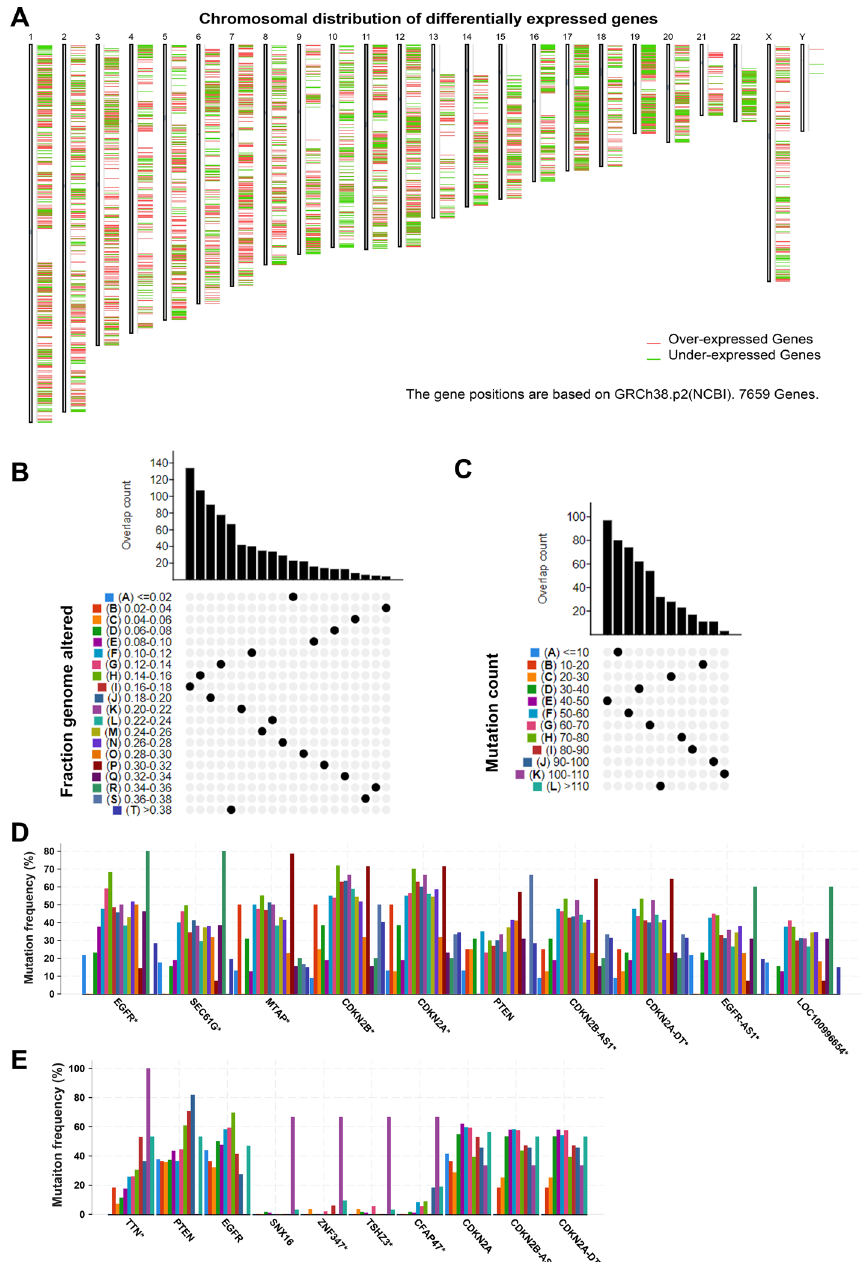
Fig. 1 Identification of potential tumor antigens in GBM. a The chromosomal distribution of up- and down-regulated genes in GBM. b Samples overlapping in the altered genome fraction group. c Samples overlapping in the mutation count group. d Genes with highest frequency in the fraction genome altered group. e Genes with highest frequency in the mutation count